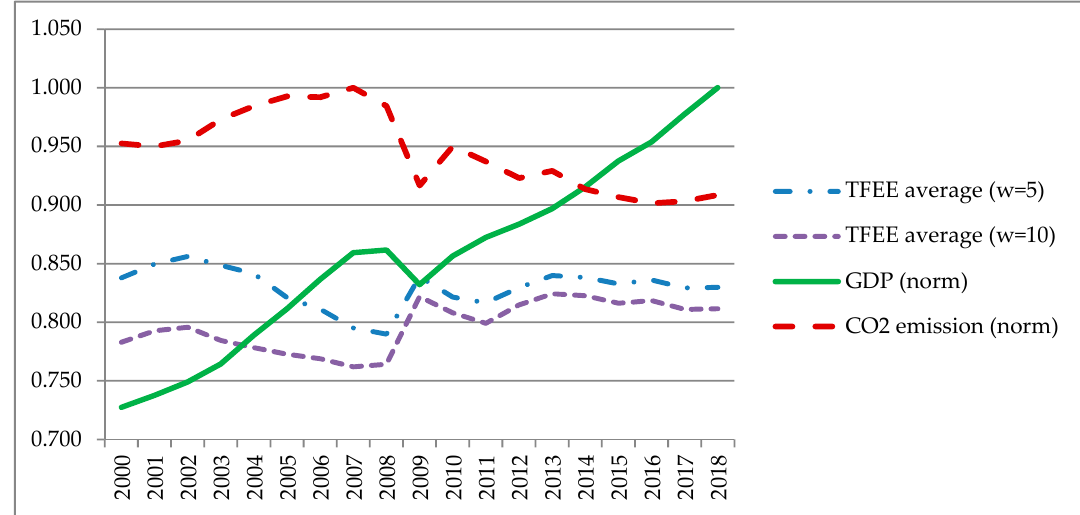
Figure 2. TFEE, GDP and CO 2 emission trends . Source: authors’ presentation.